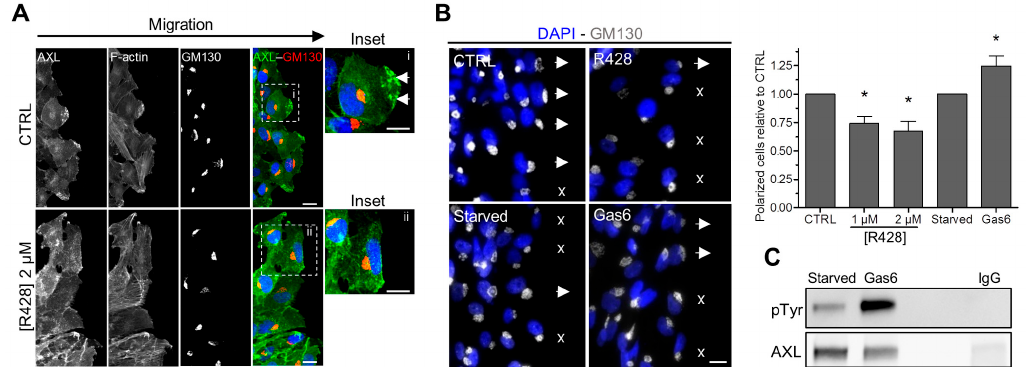
Figure 5. AXL regulates the polarized position of the Golgi apparatus during directed migration. ( A ) Representative images of Hs578t cells treated with DMSO (CTRL) or 2 µ M R428 after wound healing (4 h). The cells were stained for F-actin, AXL (Green) and GM130 (Red). Arrowheads point to AXL enrichment in polarized cell. ( B ) Left panel: representative images of Hs578t cells treated with DMSO (CTRL) or 2 µ M R428 (R428) or starved (Starved) and then stimulated with 400 ng / mL of Gas6 (Gas6) obtained from 350, 264, 280, 199 and 207 cells in three independent experiments, respectively. The cells were stained for DAPI and GM130. Arrowheads show a polarized Golgi (towards to the wound), crosses show unpolarized Golgi. Right panel: Quantification of cells possessing a polarized Golgi relative to the CTRL condition. The graph represents means and small bars indicate standard deviation (* p = 0.021; 0.022; 0.039). ( C ) Gas6 leads to AXL activation. Hs578t cells were starved and then stimulated with 400 ng / mL of Gas6 for 30 min. Phosphorylated active AXL was then detected by western blotting using an anti-phosphotyrosine antibody after AXL immunoprecipitation (as a negative control, IgG instead of AXL antibodies were used with cells treated with DMSO). Scale bars, 20 µm.